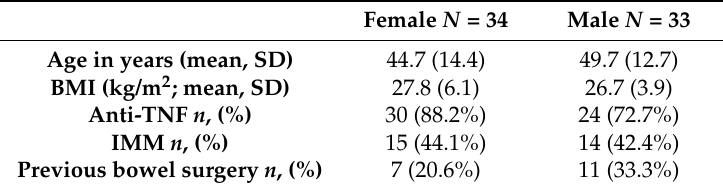
Table 1. Patient demographics and health